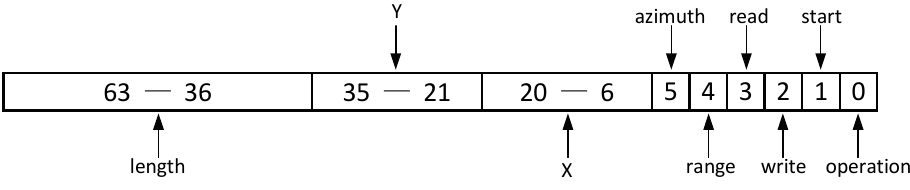
Figure 15. The arrangement of the register. Table 3. Bit definition of the register.